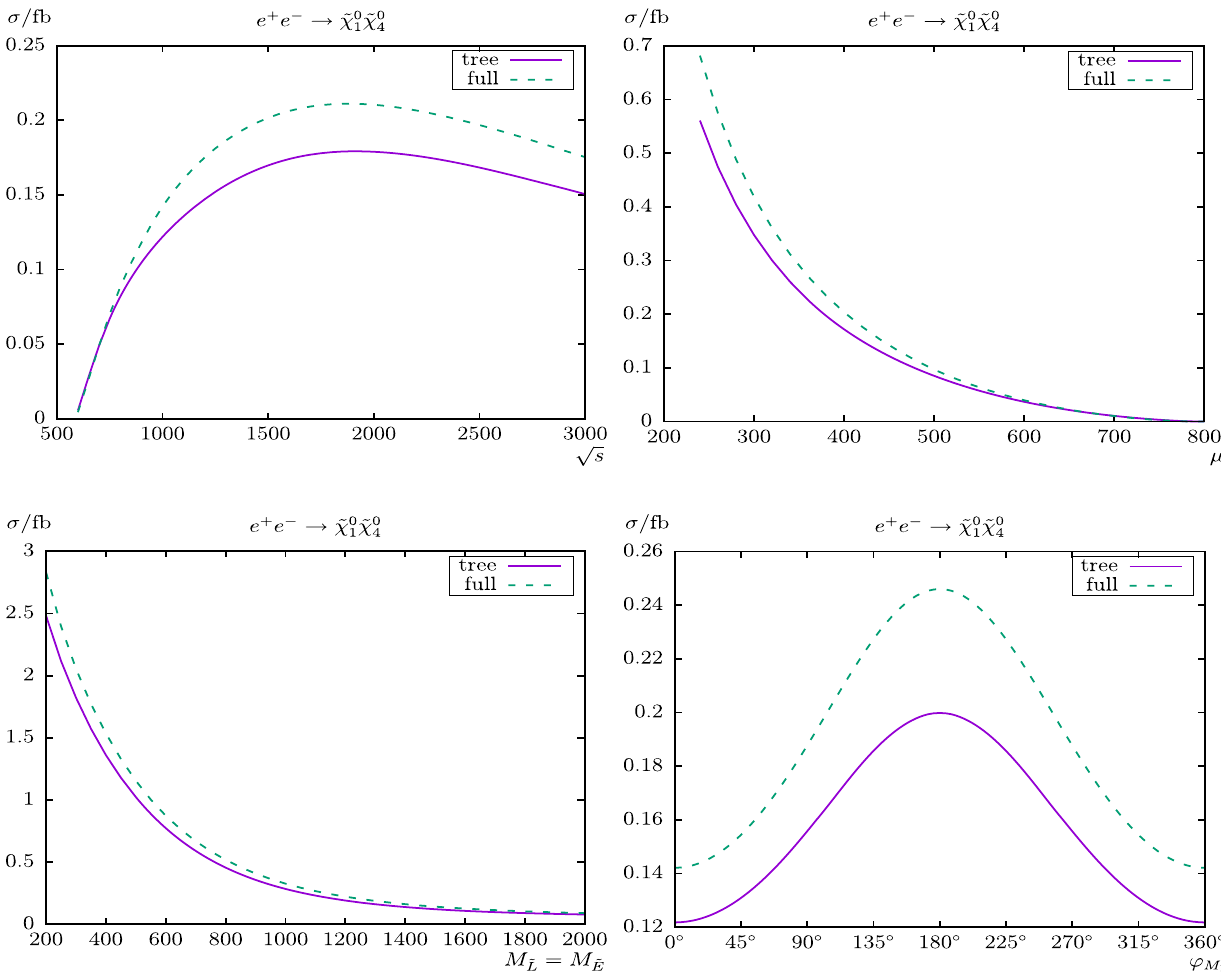
˜ χ 0 ) . Tree-level and full one-loop corrected cross sections are shown with parameters chosen according to S ; see Table 2. √ 1 4 s (left) and μ (right) varied; the lower plots show M ˜